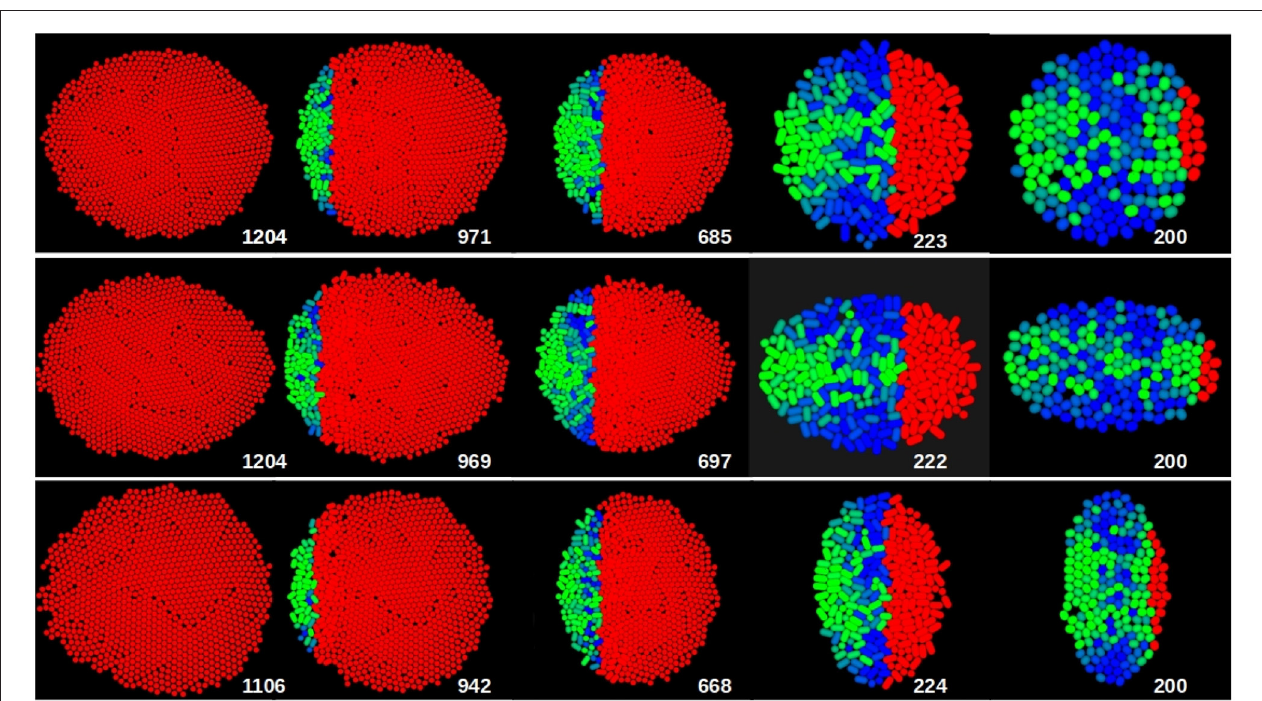
FIGURE 7 | Typical sequence ´ sof snapshots of the growth of the eye obtained by computer simulation in the case of the circular (top row), oblate (middle row) and prolate (bottom row) primordium. The number of cells is indicated in each case. The cells in P region are colored red. The color of the cells in A region is a combination between blue and green, being the green contribution the square of the component of the force over the cell, while the blue contribution is the square of the vertical component of the force over the cell. For the three cases the number of particles in the primordium was 200 and v gr = 6 σ/τ . ( X 0 , v f ) = (14.7 σ ,35 σ/τ ),(20 σ ,42 σ/τ ), and (10.6 σ ,29 σ/τ ) for circular, oblate and prolate primordium,